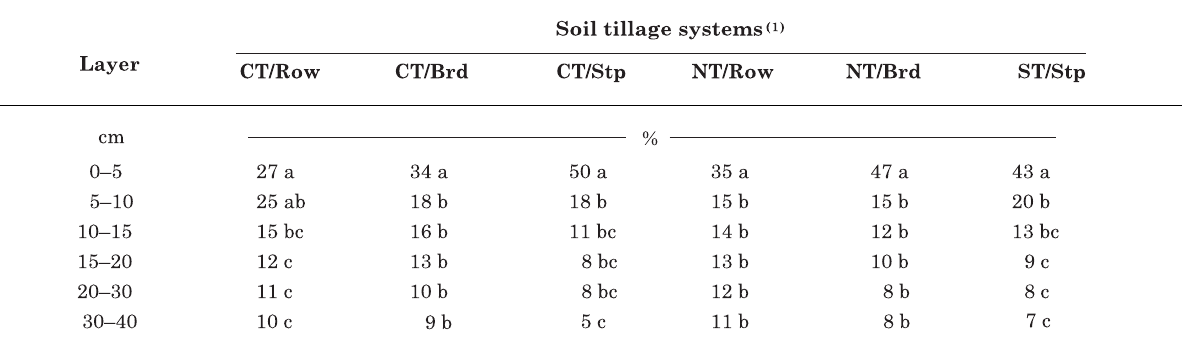
Table 1. Relative root density distribution in a Rhodic Paleudult soil profile under 18 years of different tillage systems - 2006/2007 growing season